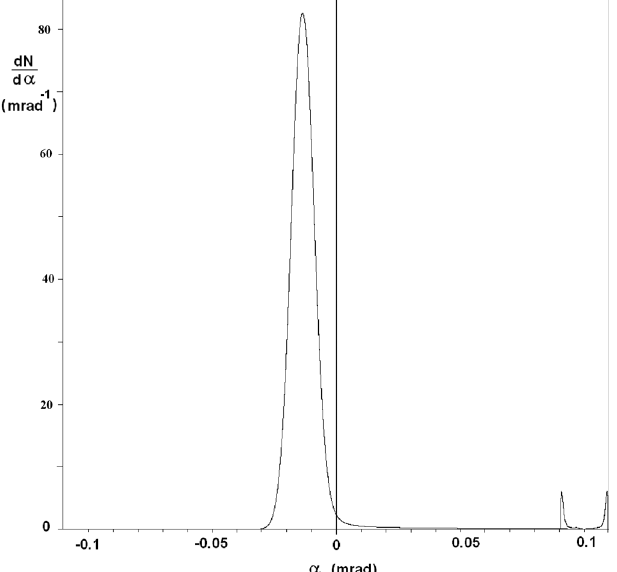
FIG. 9. The resulting distribution of scattered particles at volume reflection taking into account the influence of volume capture. The energy of protons is equal to 400 GeV, the bending radius of a 2-mm silicon single crystal is equal to 10 m.